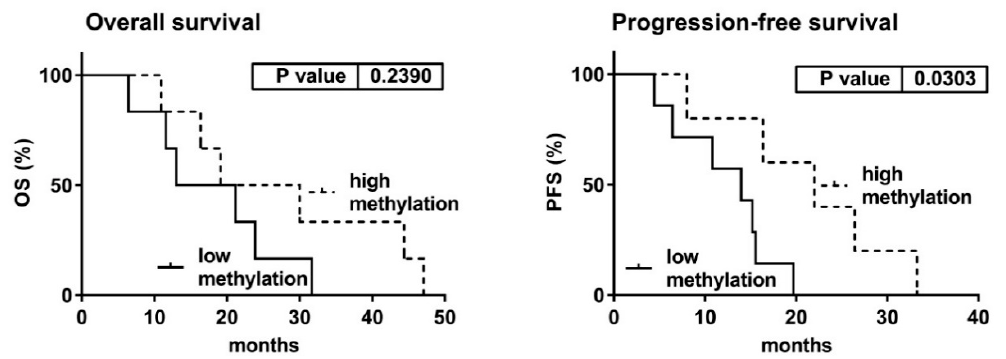
Figure 5. Patient survival after the initiation of AZA therapy according to DNA methylation of the A3 amplicon before treatment. DNA methylation in each sample was considered low or high according to the median value of overall methylation in the locus.